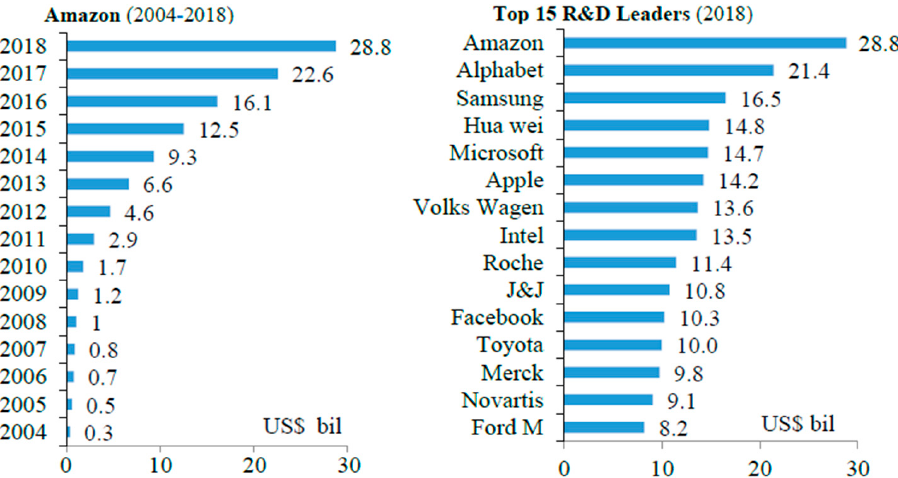
Figure 5. Amazon’s conspicuous jump to become the world’s top R&D leader—R&D investment. Sources: [64,65].